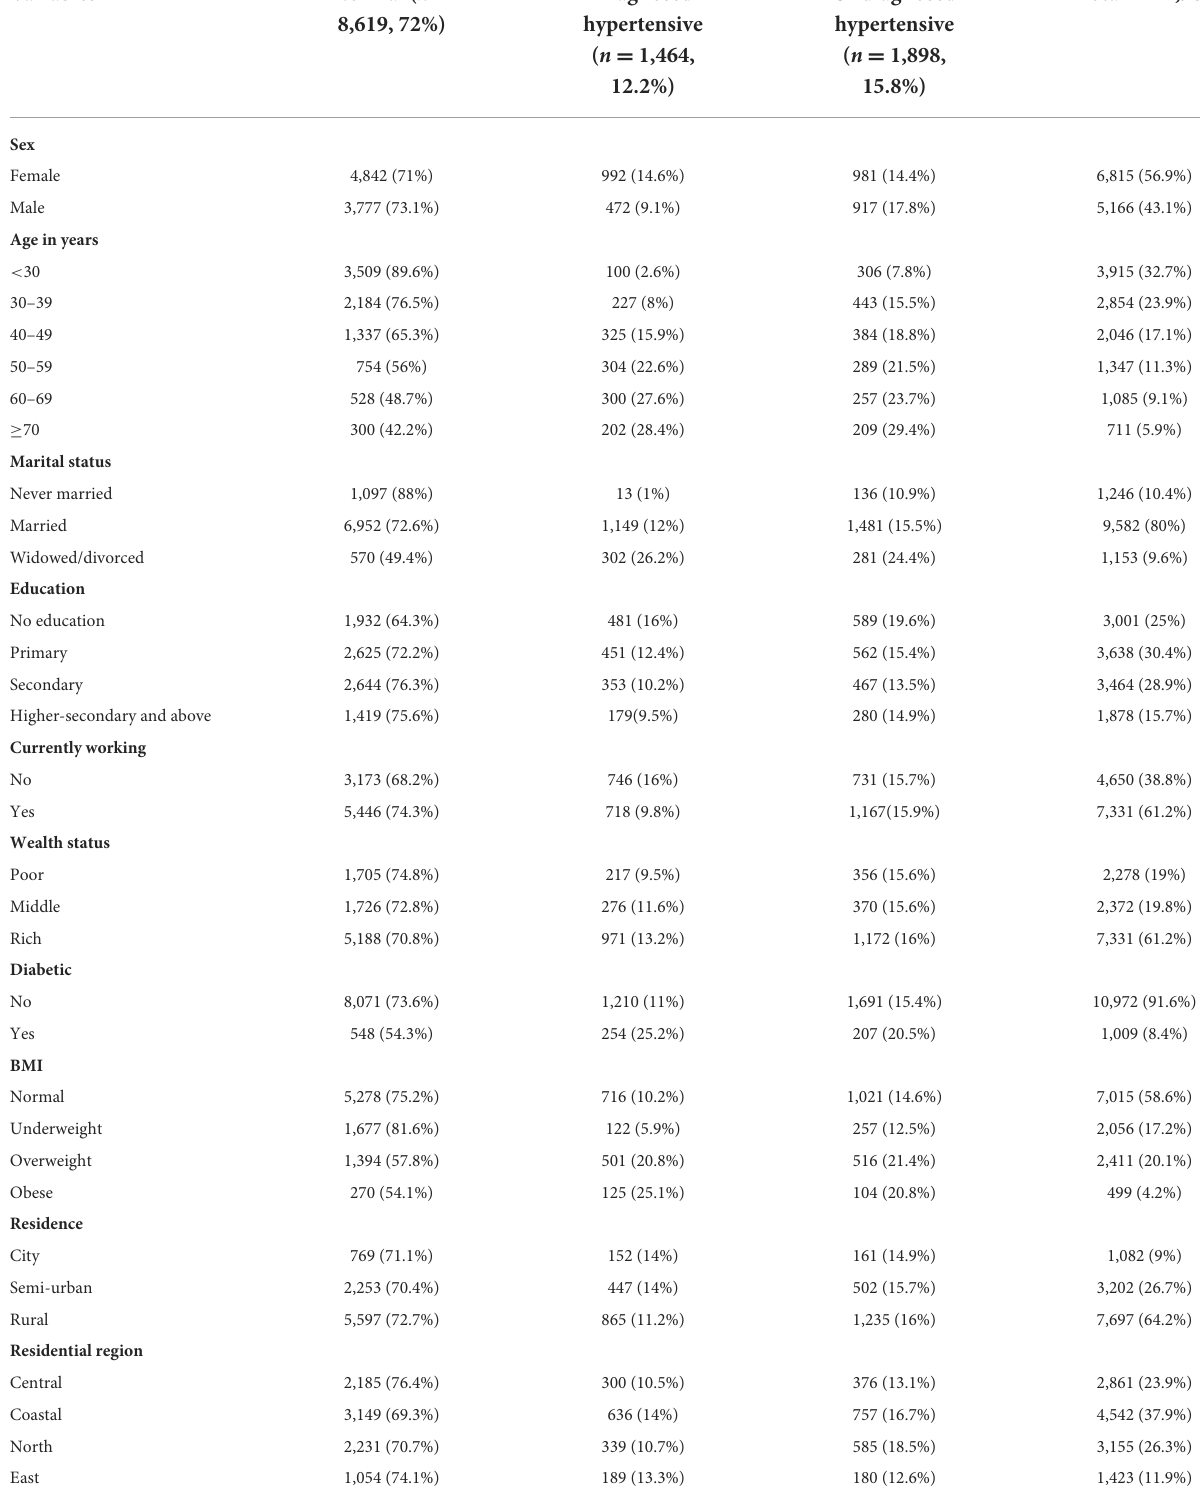
TABLE 1 Distribution of normal, hypertensive, and undiagnosed hypertensive people by socio-demographic groups of the respondents. Variables Diagnosed